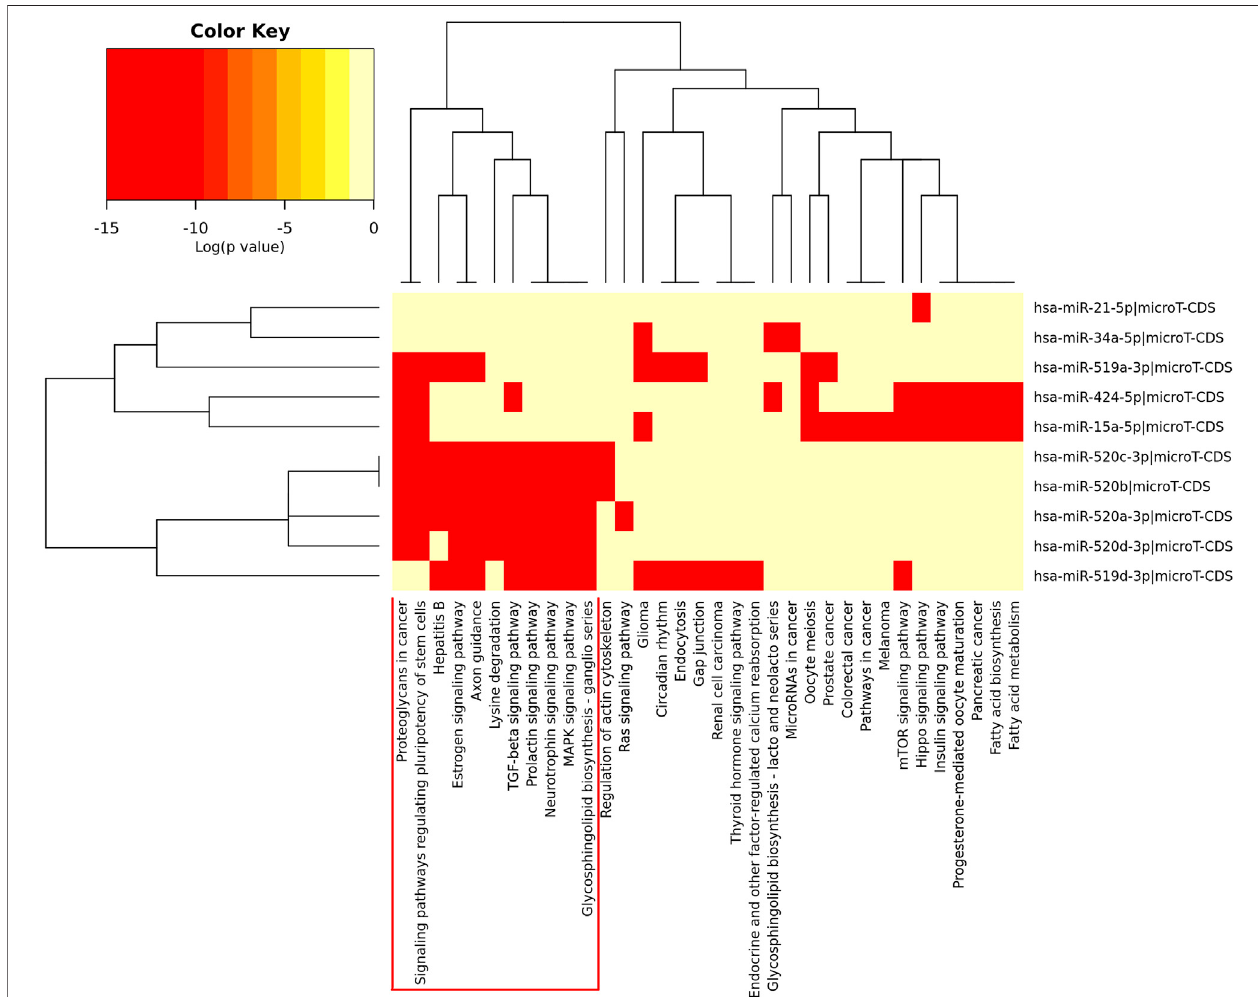
FIGURE 3 | Heatmap of pathway enrichment analysis of the hub